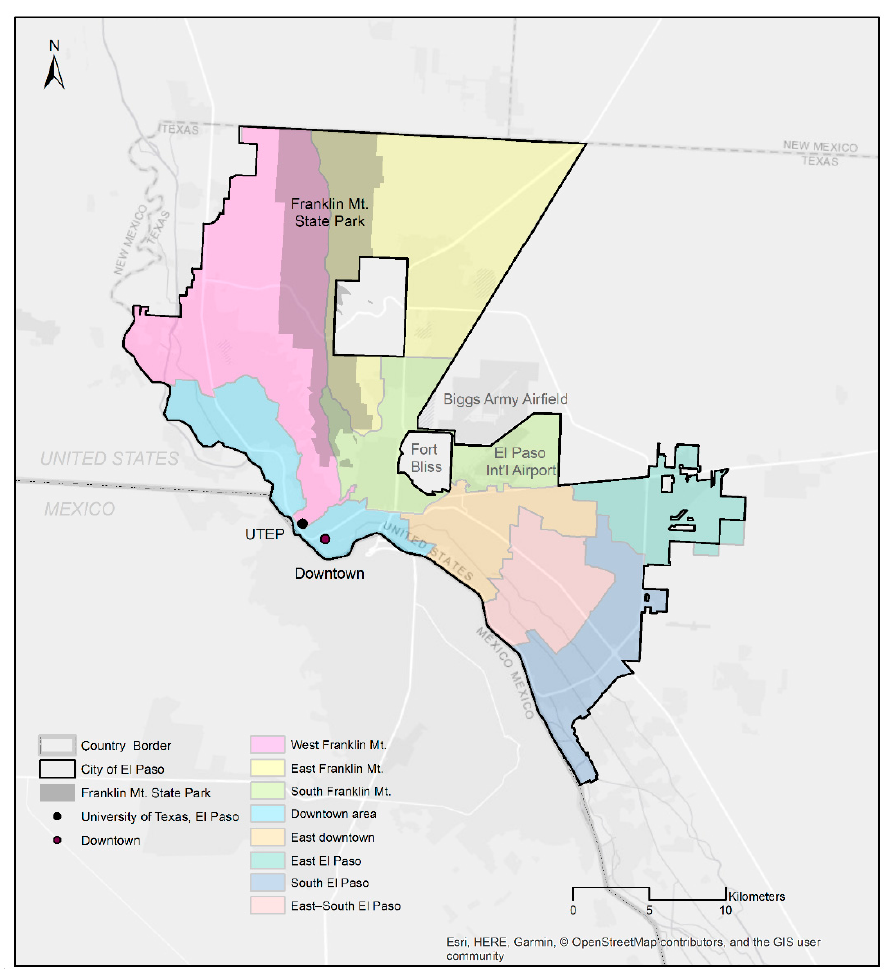
Figure 1. Study area (El Paso, Texas).